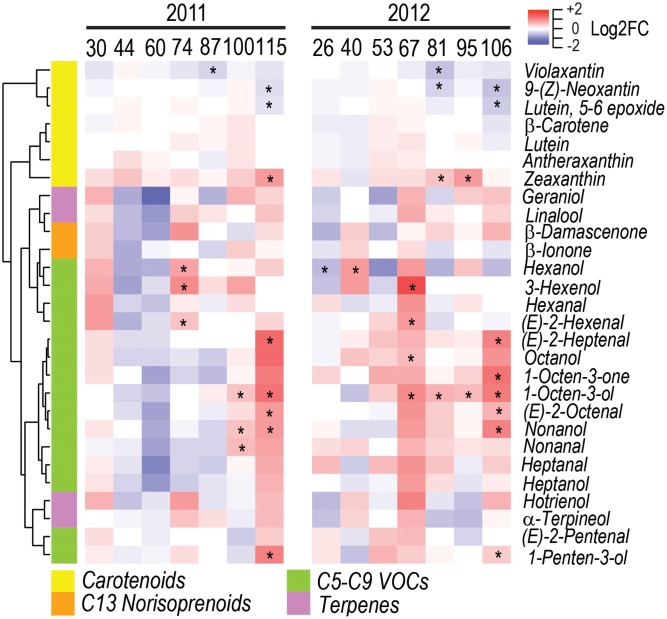
Impact of water deficit on carotenoids and free volatile organic compounds during fruit development in 2011 (left) and 2012 (right). Heatmaps represent log2FC (WD/CT) at each developmental stage. Blue and red color shades indicate lower and higher metabolite concentration in WD than CT, respectively. Asterisks indicate significant differences (P < 0.05) between treatments. Metabolites were hierarchically clustered based on their response to water deficit. The colored side bar on the left indicates the class of metabolites.